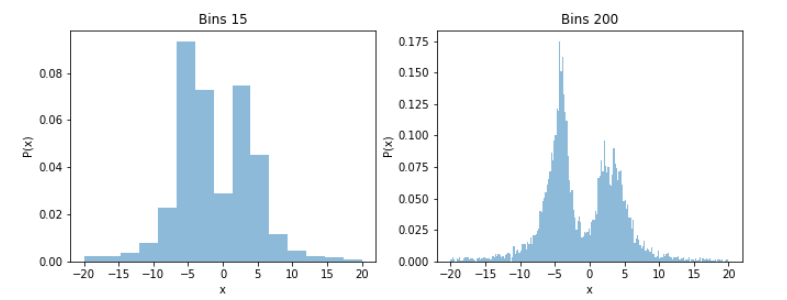
Figure 1. Cauchy data with density estimates.